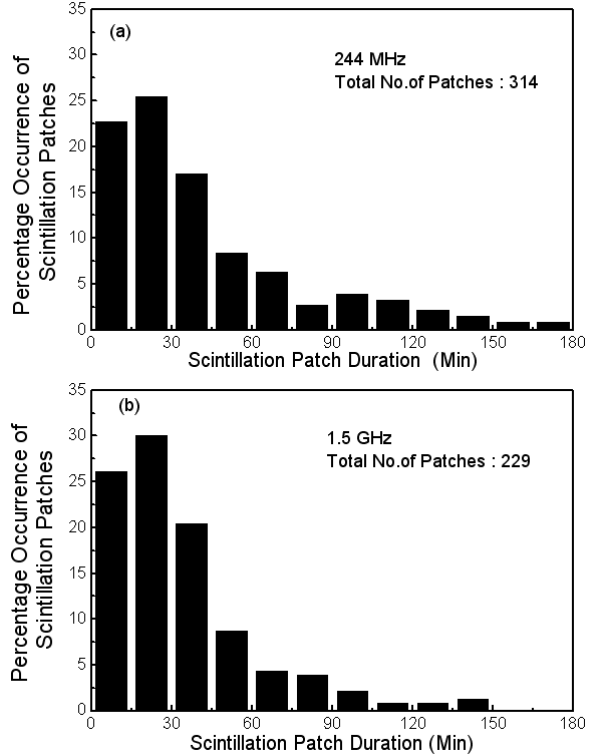
Fig. 6. Histograms showing the distribution of the patch duration of the scintillations recorded at (a) VHF and (b) L-band frequencies.